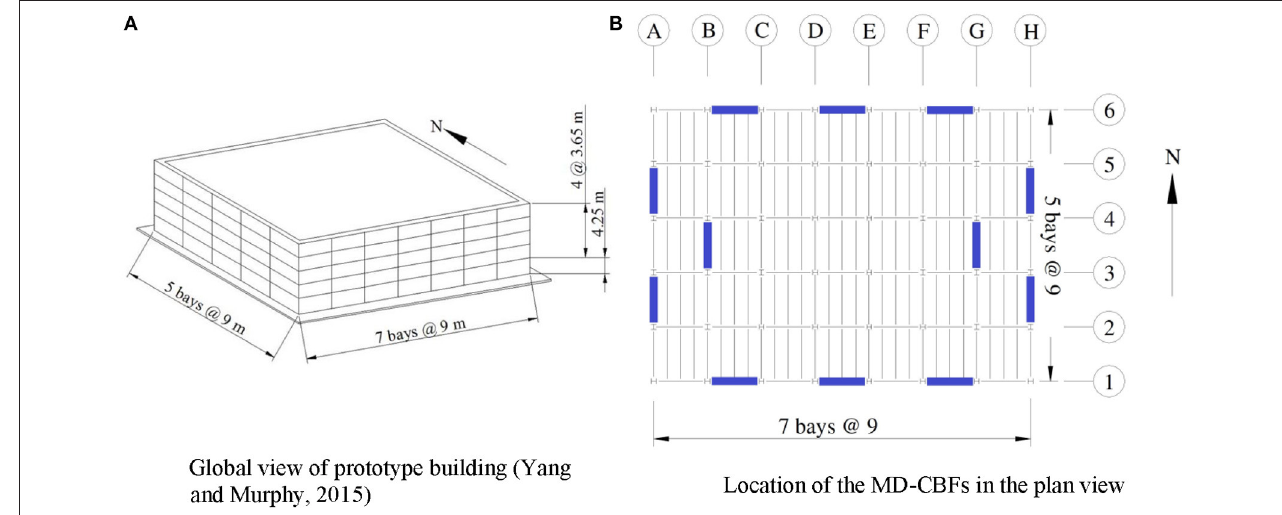
FIGURE 1 | (A) Global view of prototype building and (B) location of the MD-CBFs on the plan